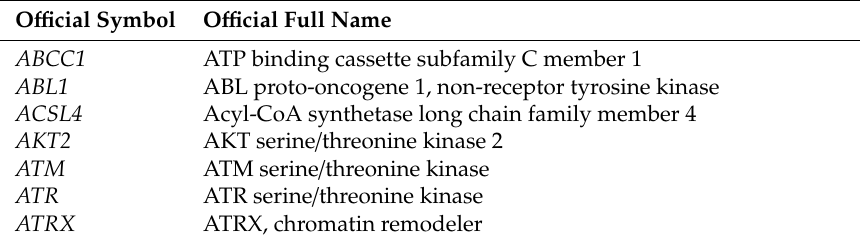
Table 1. O ffi cial full names for genes di ff erentially expressed in